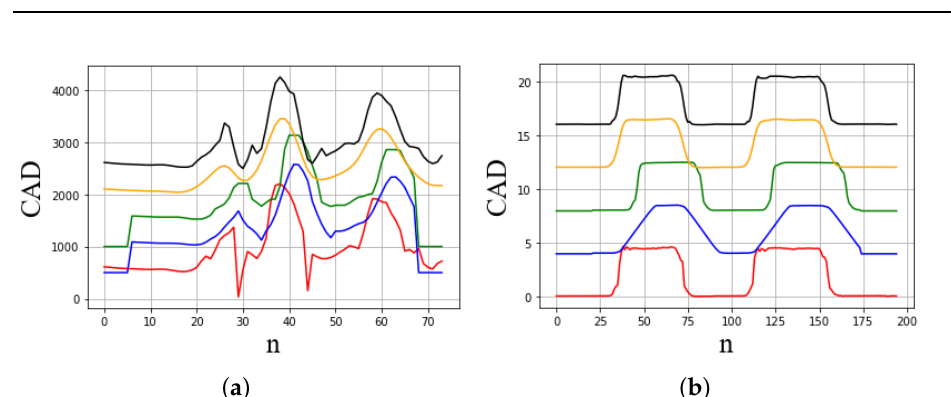
Figure 7. Smoothing graphical analysis in the proposed sensor taxonomy. ( — ) Original